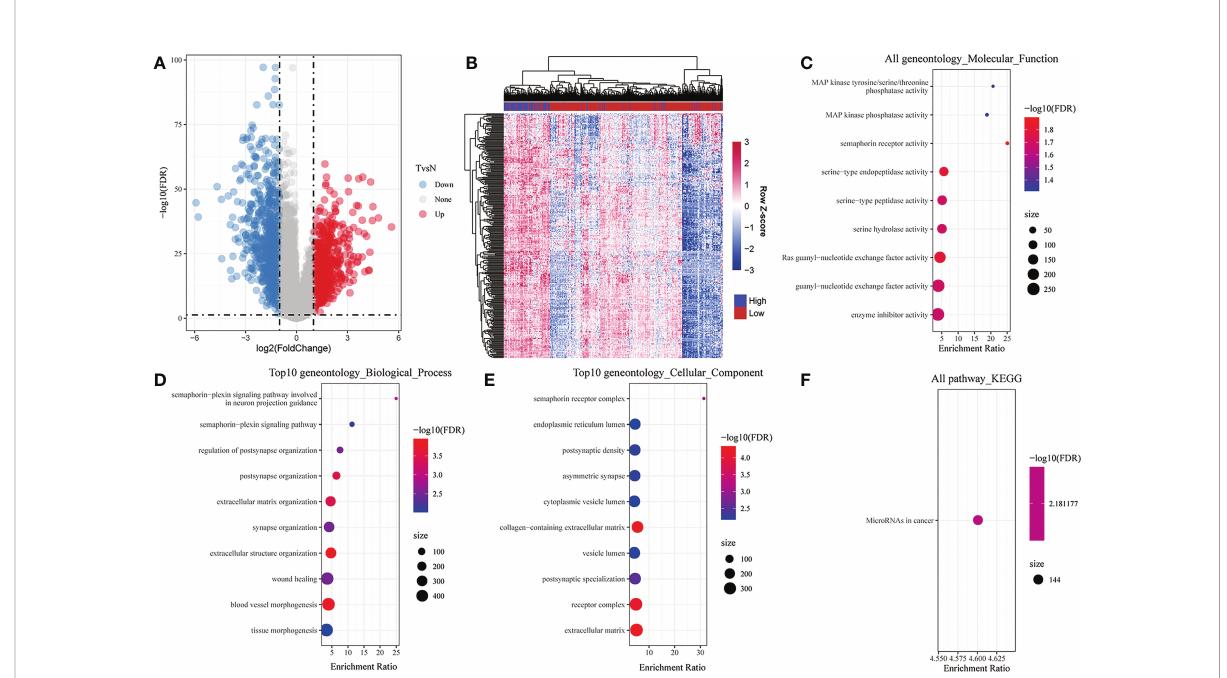
FIGURE 5 Analysis of differential genes associated with CADM1-CADM1. (A) Volcano map showing differential genes between tumor tissues and para- tumors. (B) Bidirectional Clustering Heatmap showing the relationship between CADM1-CADM1 and differential genes associated with CADM1- CADM1. Each column in the heatmap represents a sample, and each row represents the expression level of a gene. The color scale beside the heatmap represents the raw Z-score: blue (low expression), red (high expression). (C) Scatter plot of 9 enriched GO terms of molecular function (MF). (D) Scatter plot of top 10 enriched GO terms of biological process (BP). (E) Scatter plot of top 10 enriched GO terms of cellular component (CC). (F) KEGG enrichment analysis of differential genes associated with